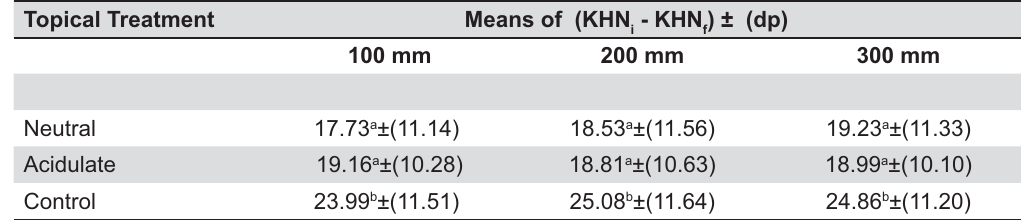
- KHN ) for the topical treatments i f